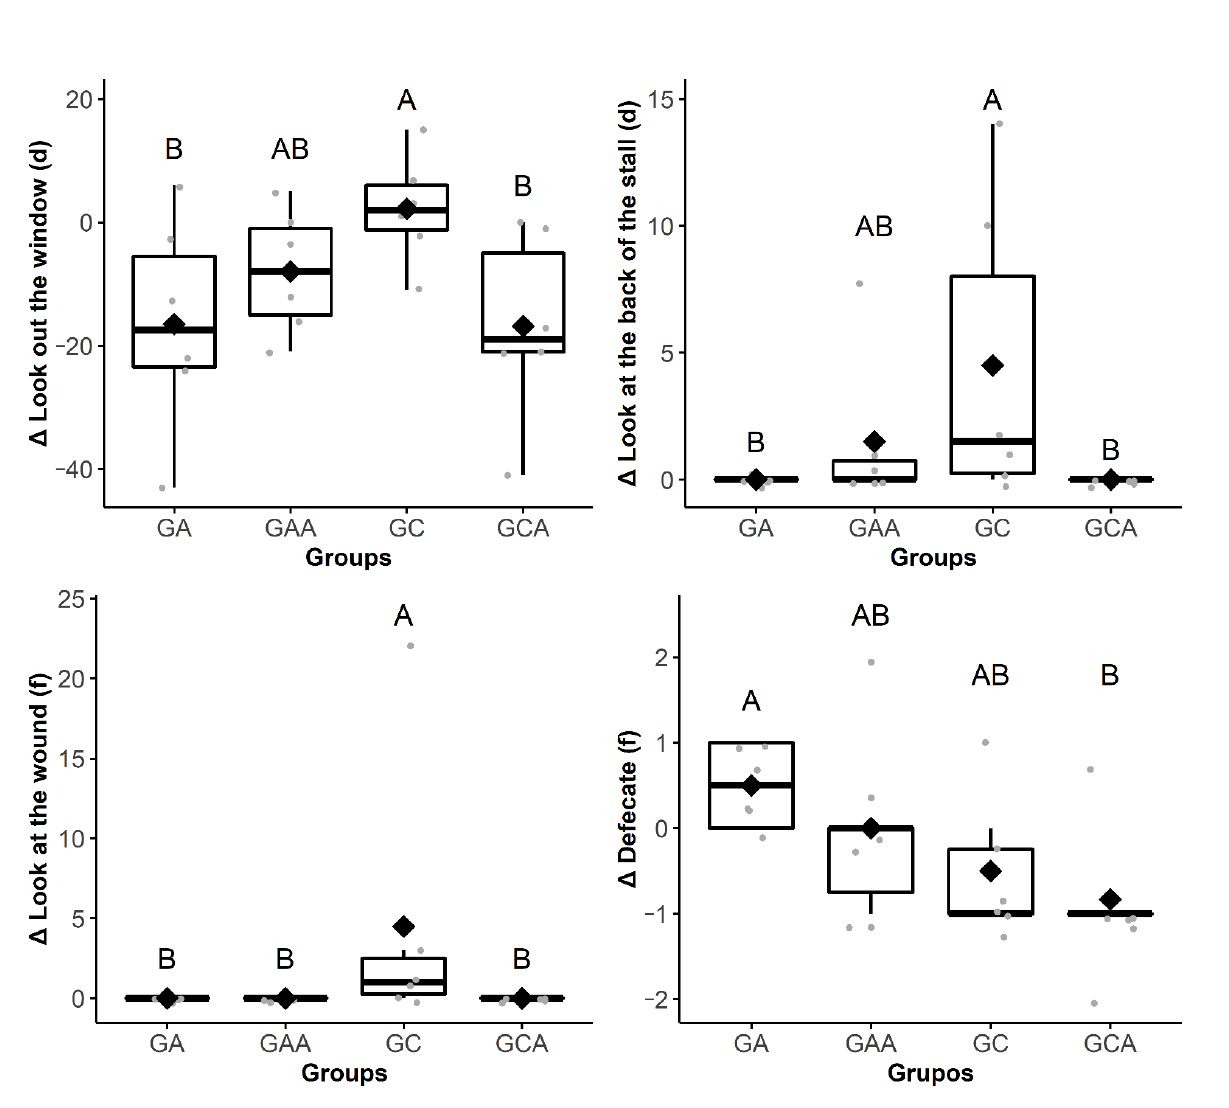
Figure 3. Boxplot ∆ 2 h (11:18 ± 00:22) showing the differences in the frequency (f) or duration (d) of the behaviors look out the window d , at the back of the stall d , and at the wound f , and defecate f among the groups of horses submitted to anesthesia (GA), preoperative analgesia and anesthesia and analgesia (GAA), anesthesia, orchiectomy, postoperative analgesia (GC) and preoperative analgesia, anesthesia, orchiectomy (GCA). The delta (∆) is the subtraction of the behaviors frequency or duration recorded after the anesthesia from those recorded in the mirrored hours before the anesthesia. Different uppercase letters indicate a significant difference over time (A > B). The gray dots represent each horse.